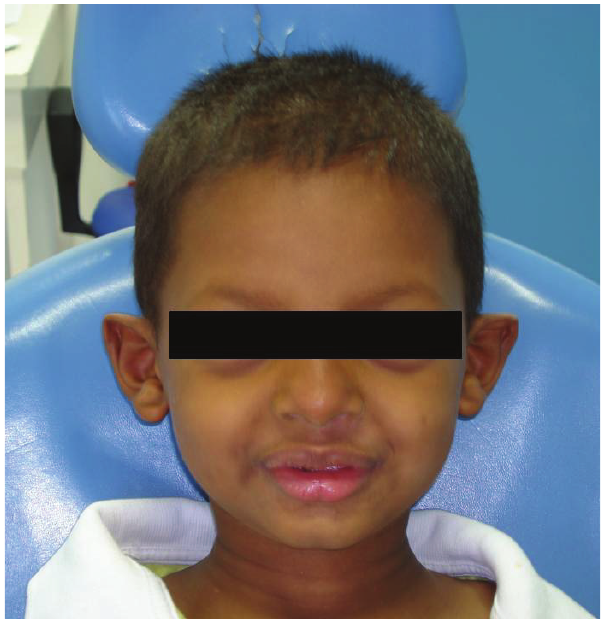
Figure 1: The patient exhibited hypotrichosis, dry skin, periocular hyperpigmentation, and protruding lips.